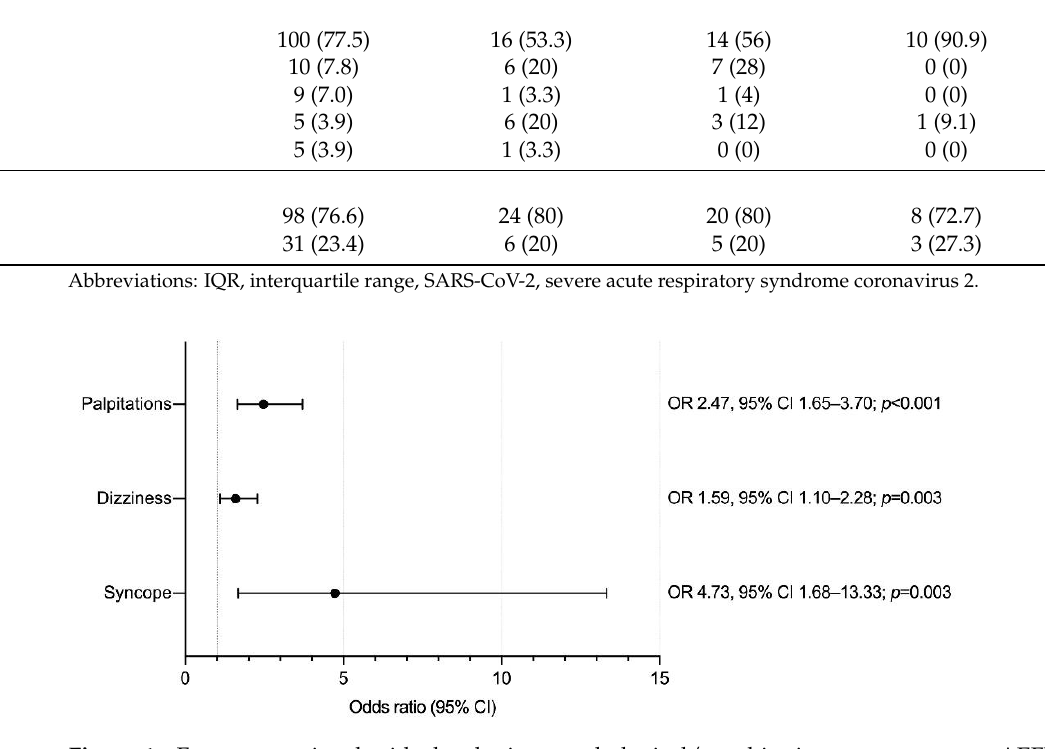
Figure 1. Factors associated with developing psychological/psychiatric symptoms as an AEFI among recipients of five different vaccines against SARS-CoV-2. Abbreviations: OR, odds ratio, CI, confidence interval. Model adjusted for age, sex, medical history, timing from vaccination, and reported symptoms.